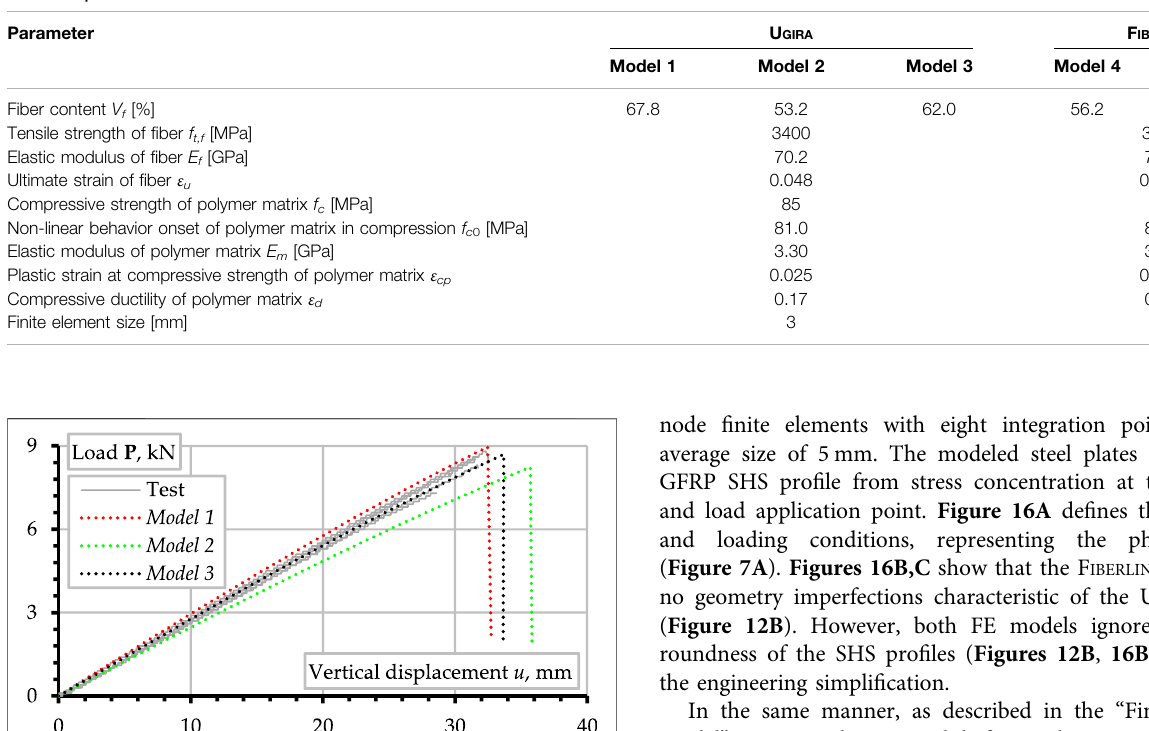
TABLE 3 | Parameters of the numerical models.